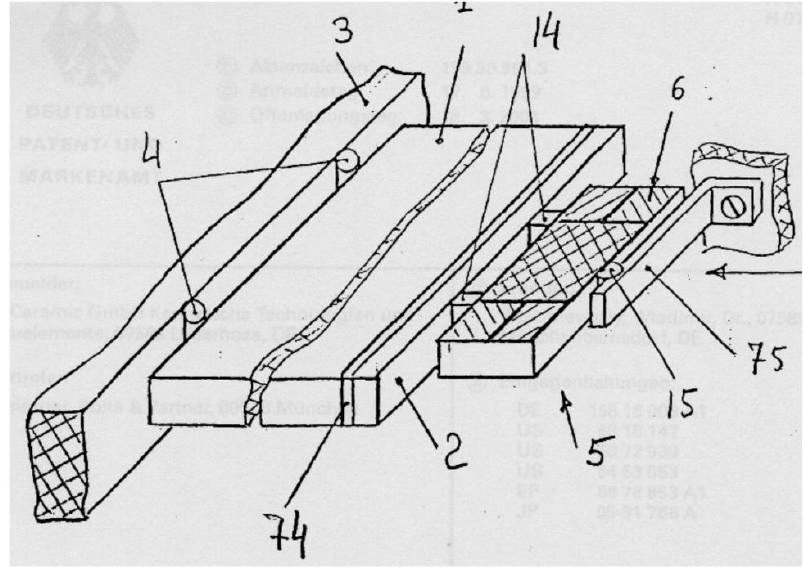
Figure 12. Two-phase motor from Physik Instrumente (PI) [39].